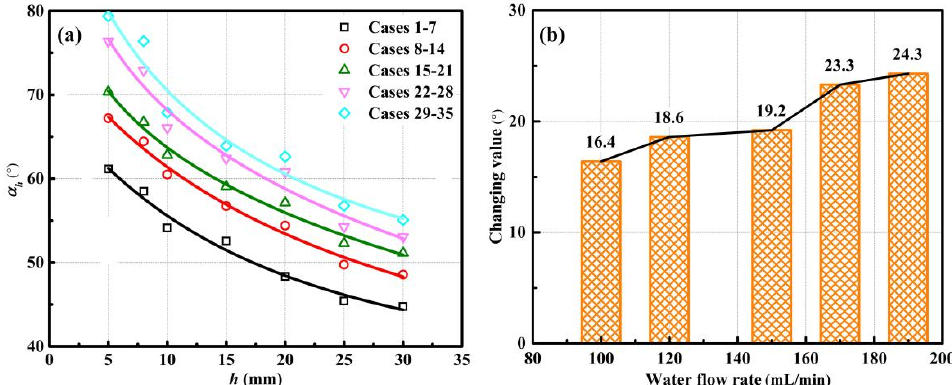
Figure 3. Actual spray angles of the pressure-swirl nozzle, ( a ) variations of the actual spray cones with the impingement distance, ( b ) changing values of the actual spray angles at a fixed mass flow rate.